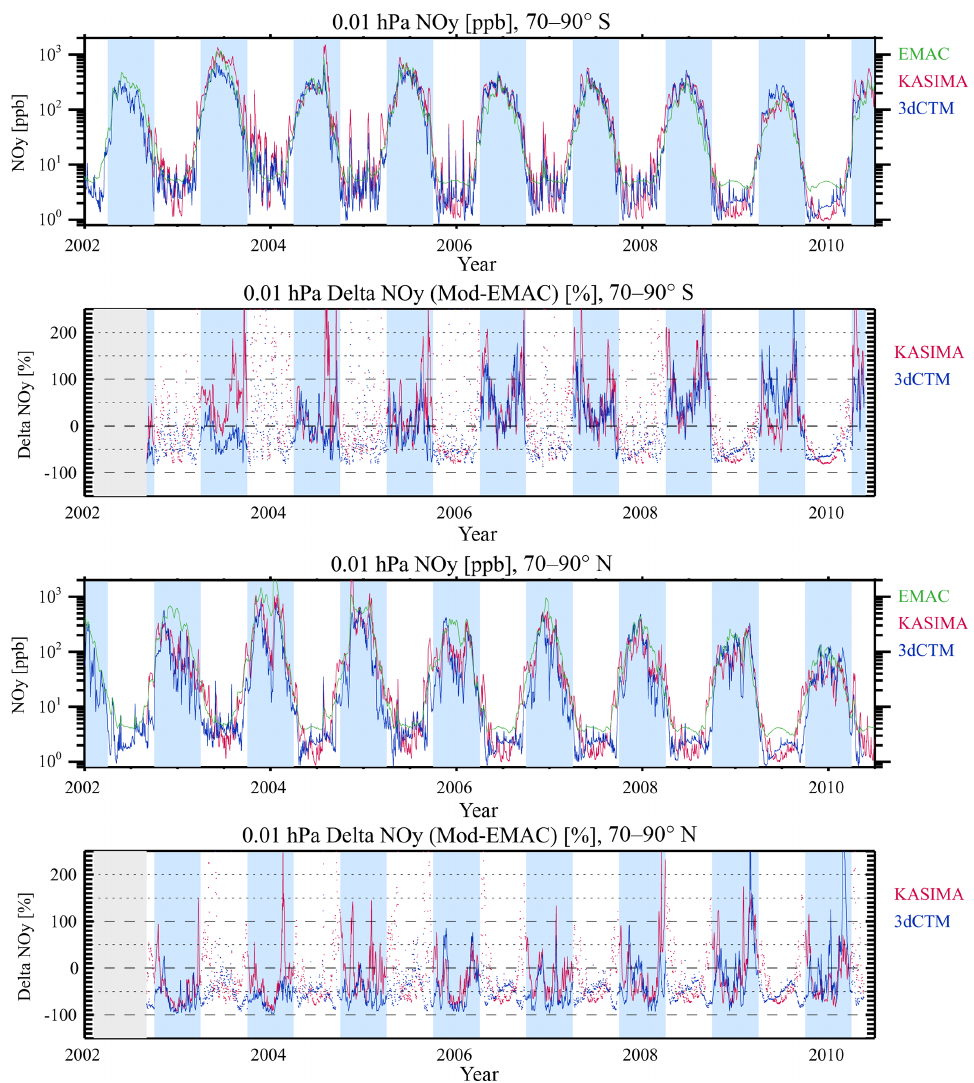
Figure 2. Temporal evolution of the volume mixing ratio of NO y (ppb) from all three models at high southern and northern latitudes (70– 90 ◦ S/N), at 0.01hPa. Also shown are relative differences from KASIMA and 3dCTM to EMAC results (%). Light blue shading denotes winter in the Southern Hemisphere/Northern Hemisphere (second and third quarters of each year/first and fourth quarters of each year). The gray shading in the difference plots denotes the period at the start where KASIMA results were not yet available. To highlight differences in polar winter, differences in summer are shown as dots, while differences in winter are shown as solid lines. KASIMA: red; 3dCTM: blue; EMAC: